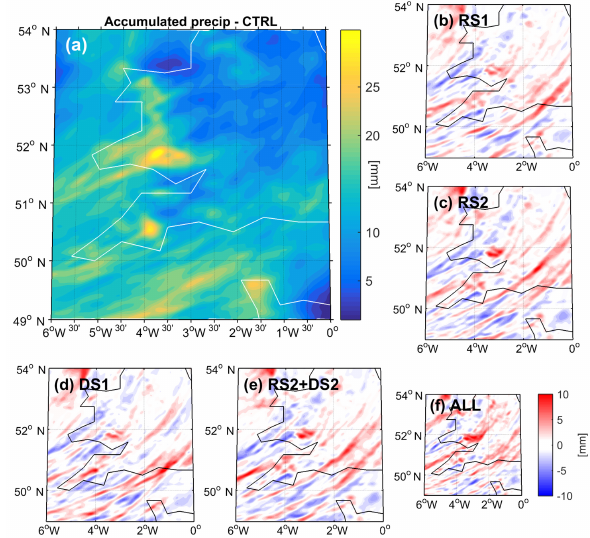
Figure 8. Panel (a) shows the spatial distribution of accumulated precipitation in the control simulation for a small domain near CFARR at 23:30UTC, after full passage of the rainband over the UK. Panels (a) – (f) show the deviations of accumulated precipitation in five of the simulations with the secondary ice parameterizations in place.